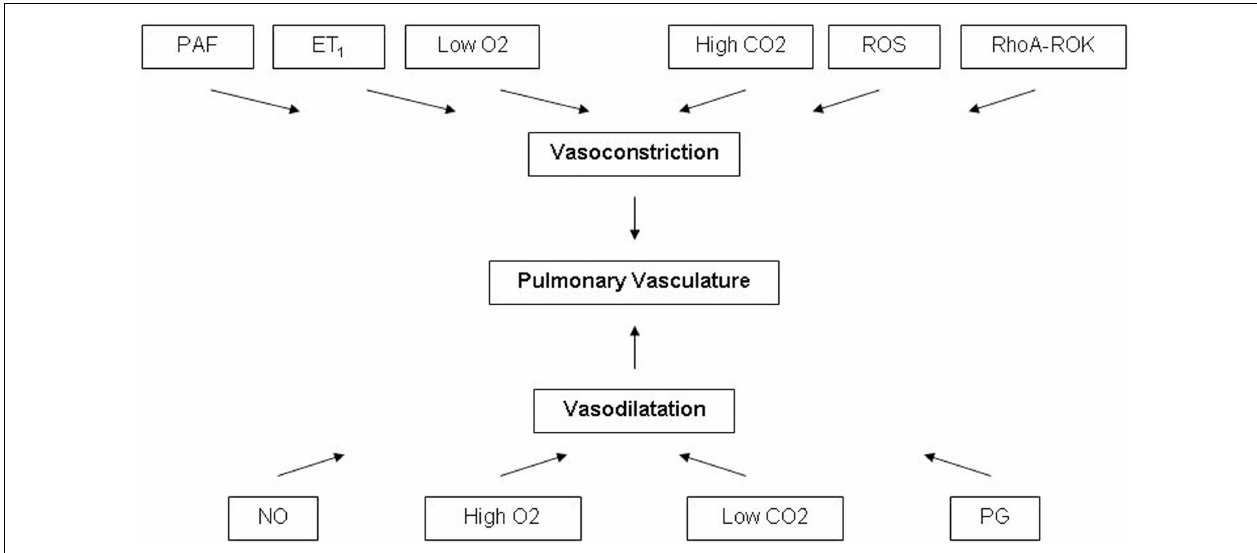
FIGURE 1 | Factors affecting the pulmonary vasculature tone . PAF, platelet activating factor; ET1, endothelin-1; ROS, reactive oxygen species; RhoA-ROK, Rho A-Rho kinase; O 2 , oxygen; CO 2 , carbon dioxide; NO, nitric oxide; PG,